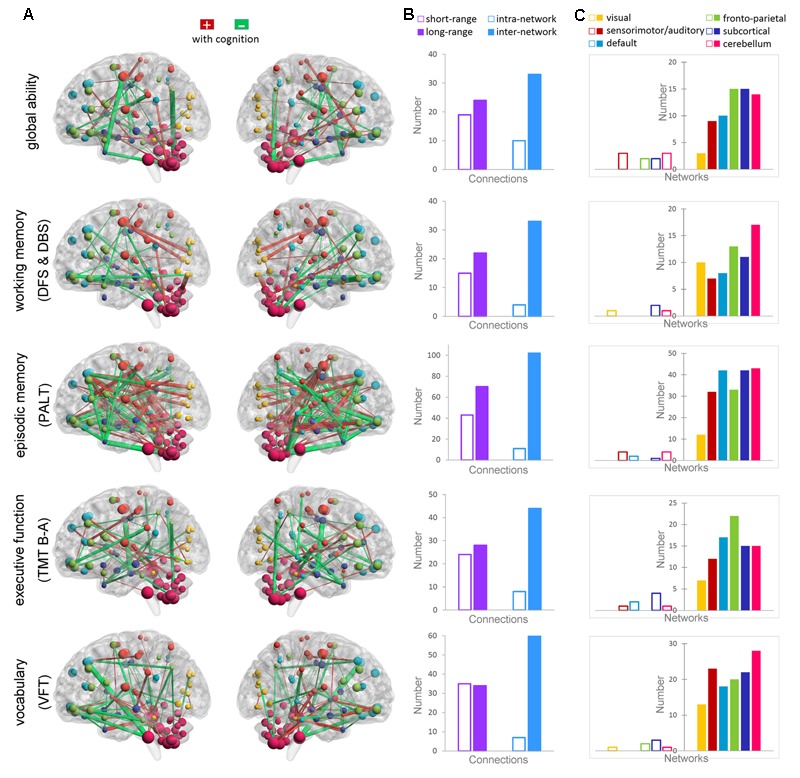
Correlations between functional connectivity and the cognitive measures of global ability, working memory (DFS and DBS), episodic memory (PALT), executive function (TMT B-A), and vocabulary ability (VFT). (A) Maps showing significant correlations between the connectivity and cognitive ability (p < 0.01). The connections that positively correlated with cognition are shown in red, whereas the connections that negatively correlated with cognition are shown in green. The thickness of the connections is proportional to the connectivity–cognition correlation coefficients. (B) The bars show the total number of short-range and long-range connections, as well as the intra-network and inter-network connections that are correlated with each cognitive domain. (C) The bars show the total number of connections within each functional network (transparent bars) and the total number of connections with other networks (non-transparent bars) that are correlated with each cognitive domain.